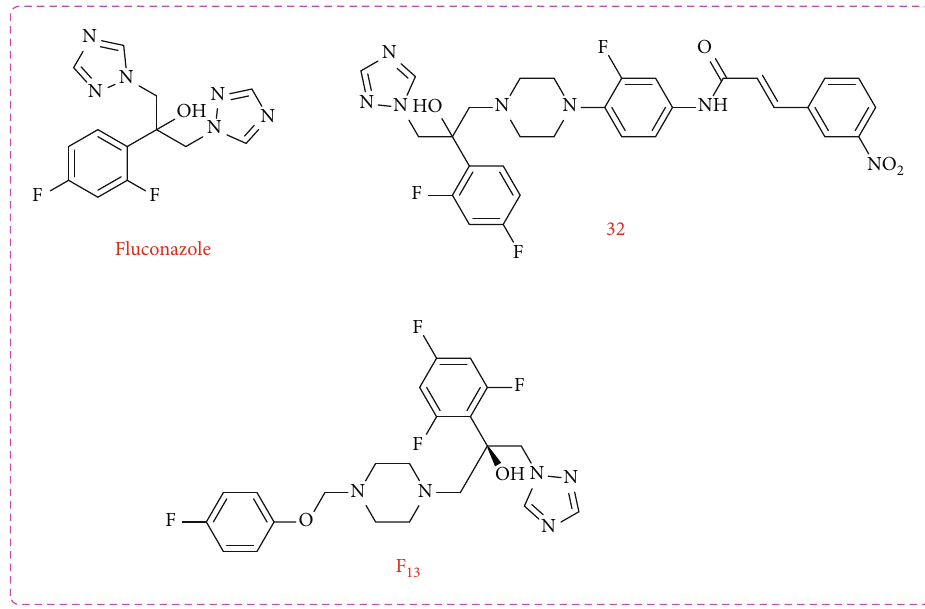
Figure 7: Two-dimensional structure of fl uconazole, 32, and